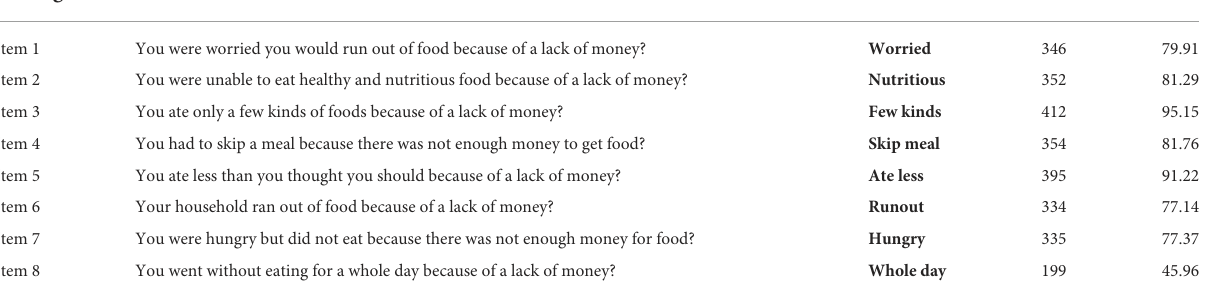
TABLE 2 Raw score of responses by all respondents to FIES questions ( n = 433) by food insecurity domain. During the last 12 months, was there a time